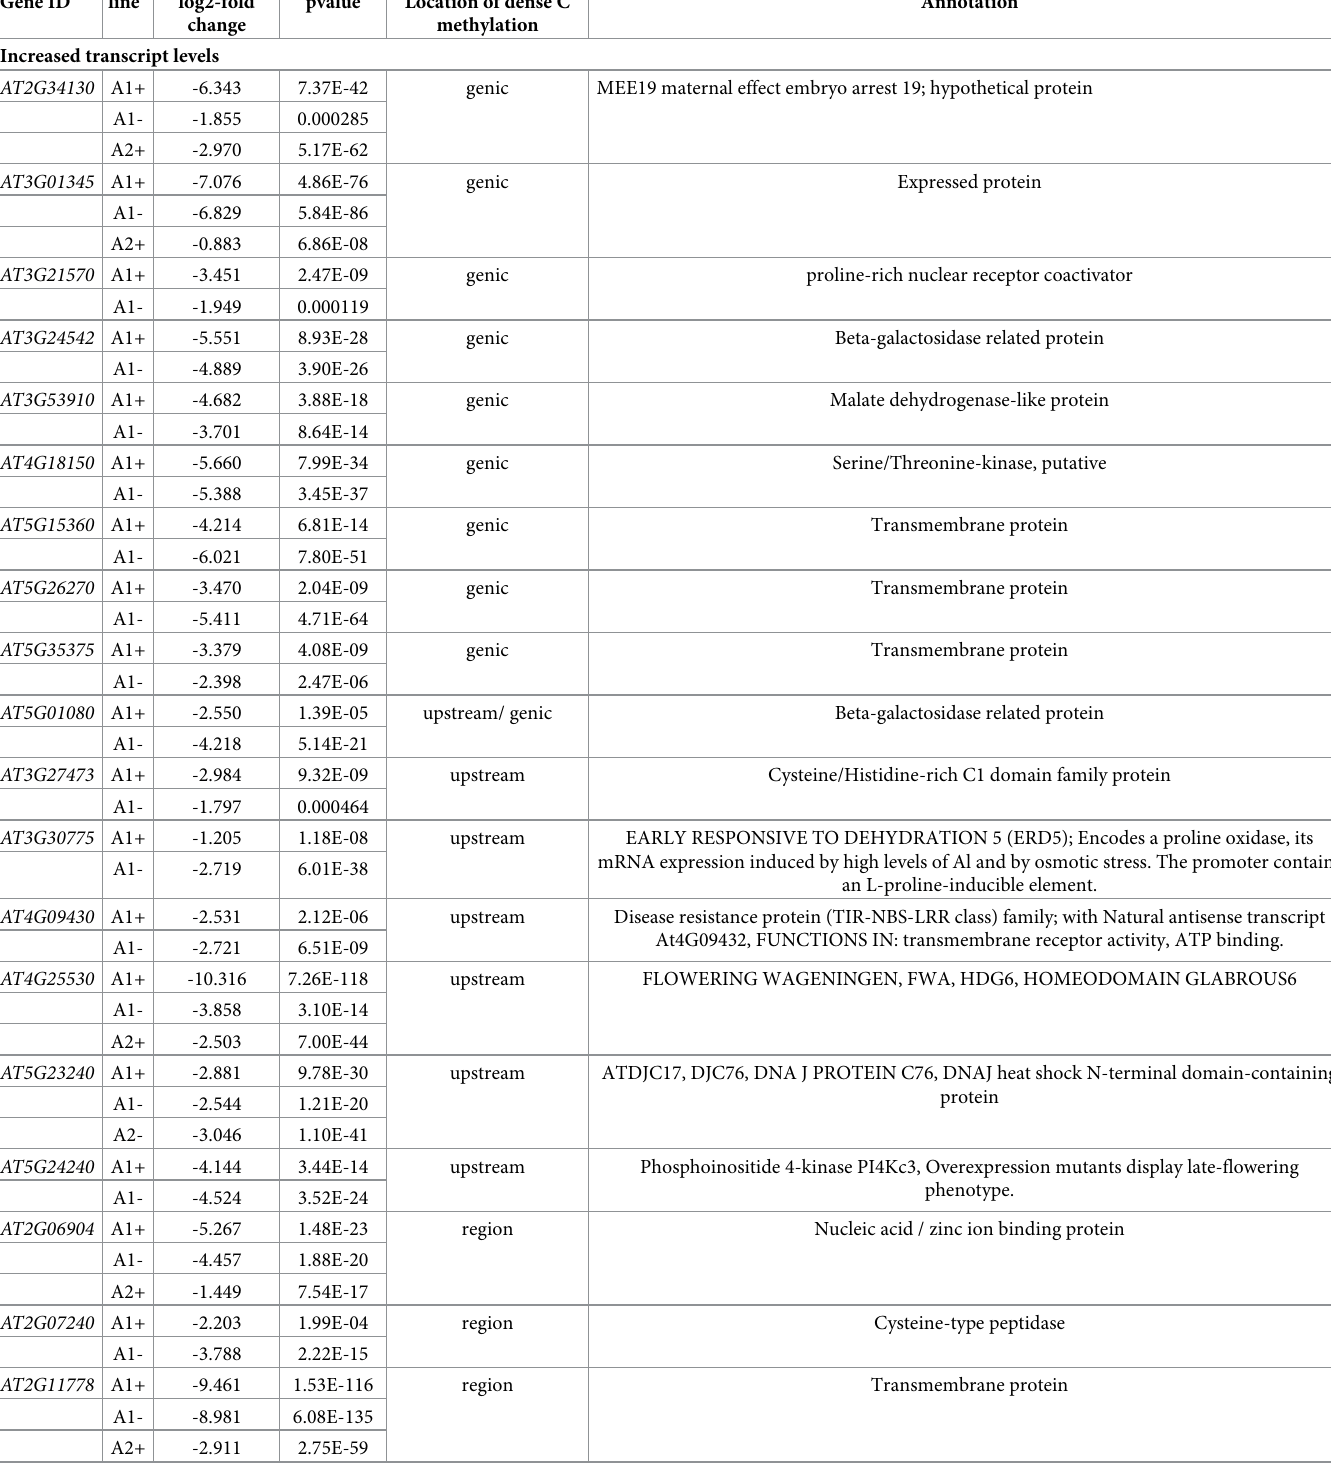
Table 2. List of all coding genes with heritably increased (negative log2-fold change) or reduced (positive log2-fold change) transcript levels in the A1 lines with dense cytosine methylation in all three sequence contexts (CG, CHG, CHH). Gene